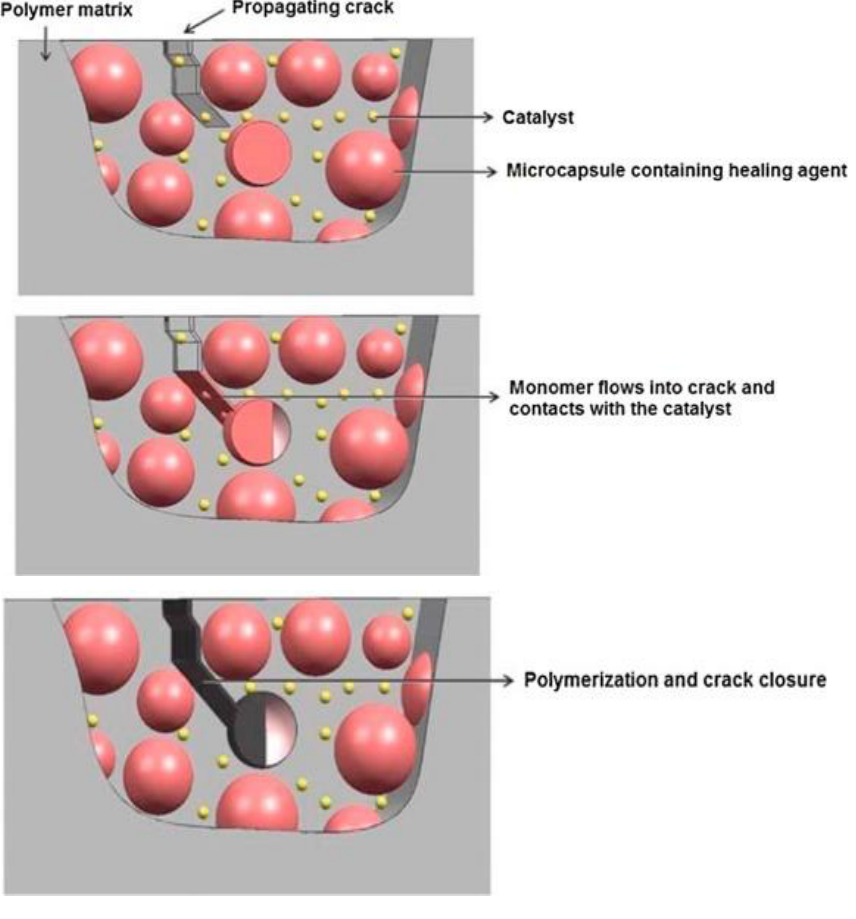
Figure 2. Self-healing process using microcapsules [21]. Table 1. Factors to be considered while developing microcapsule embedded matrix.